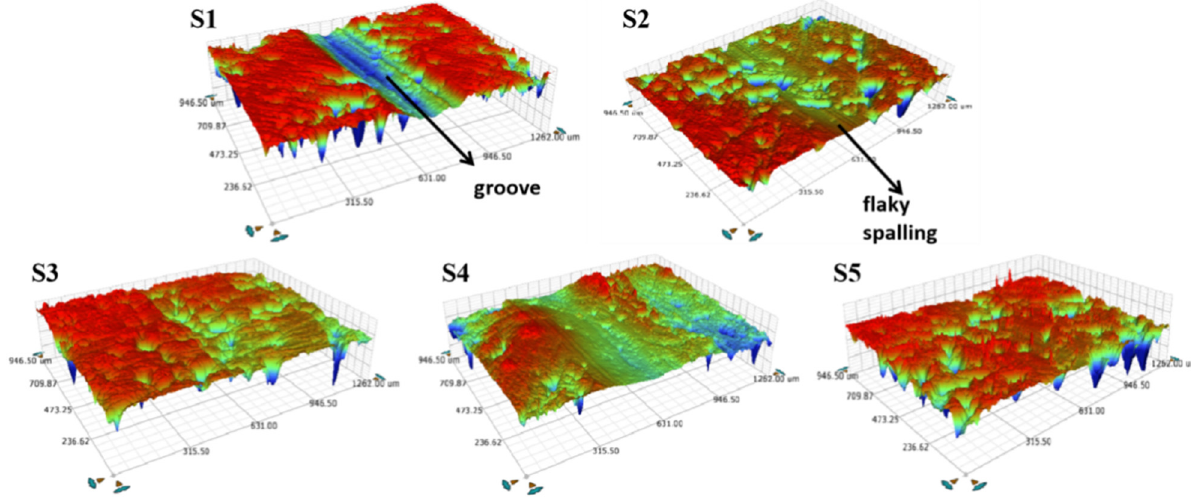
Figure 13: 3D Images and surface pro fi les of wear tracks of the S1 – S5 samples.